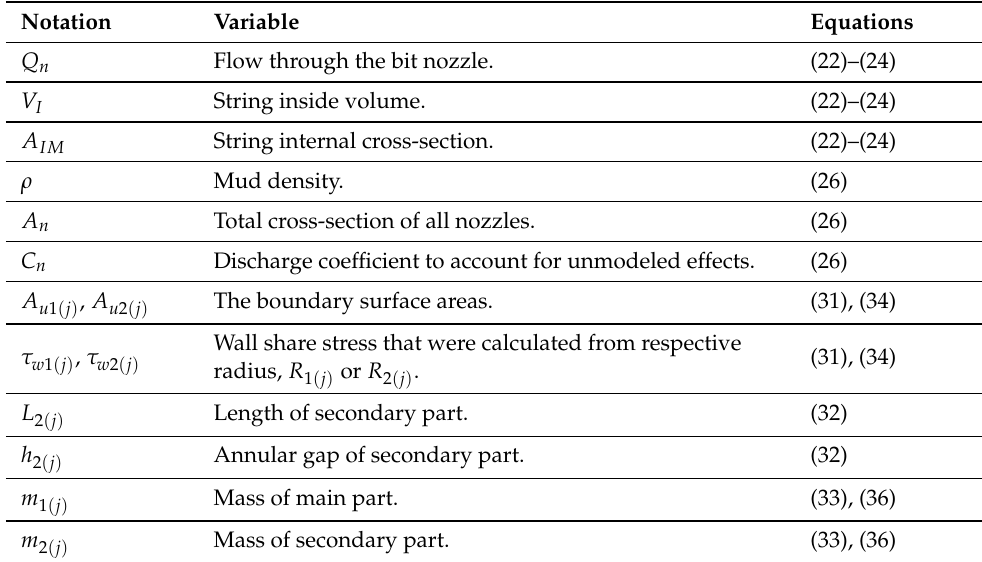
Table 2. The variables used in the model by Gjerstad et al.